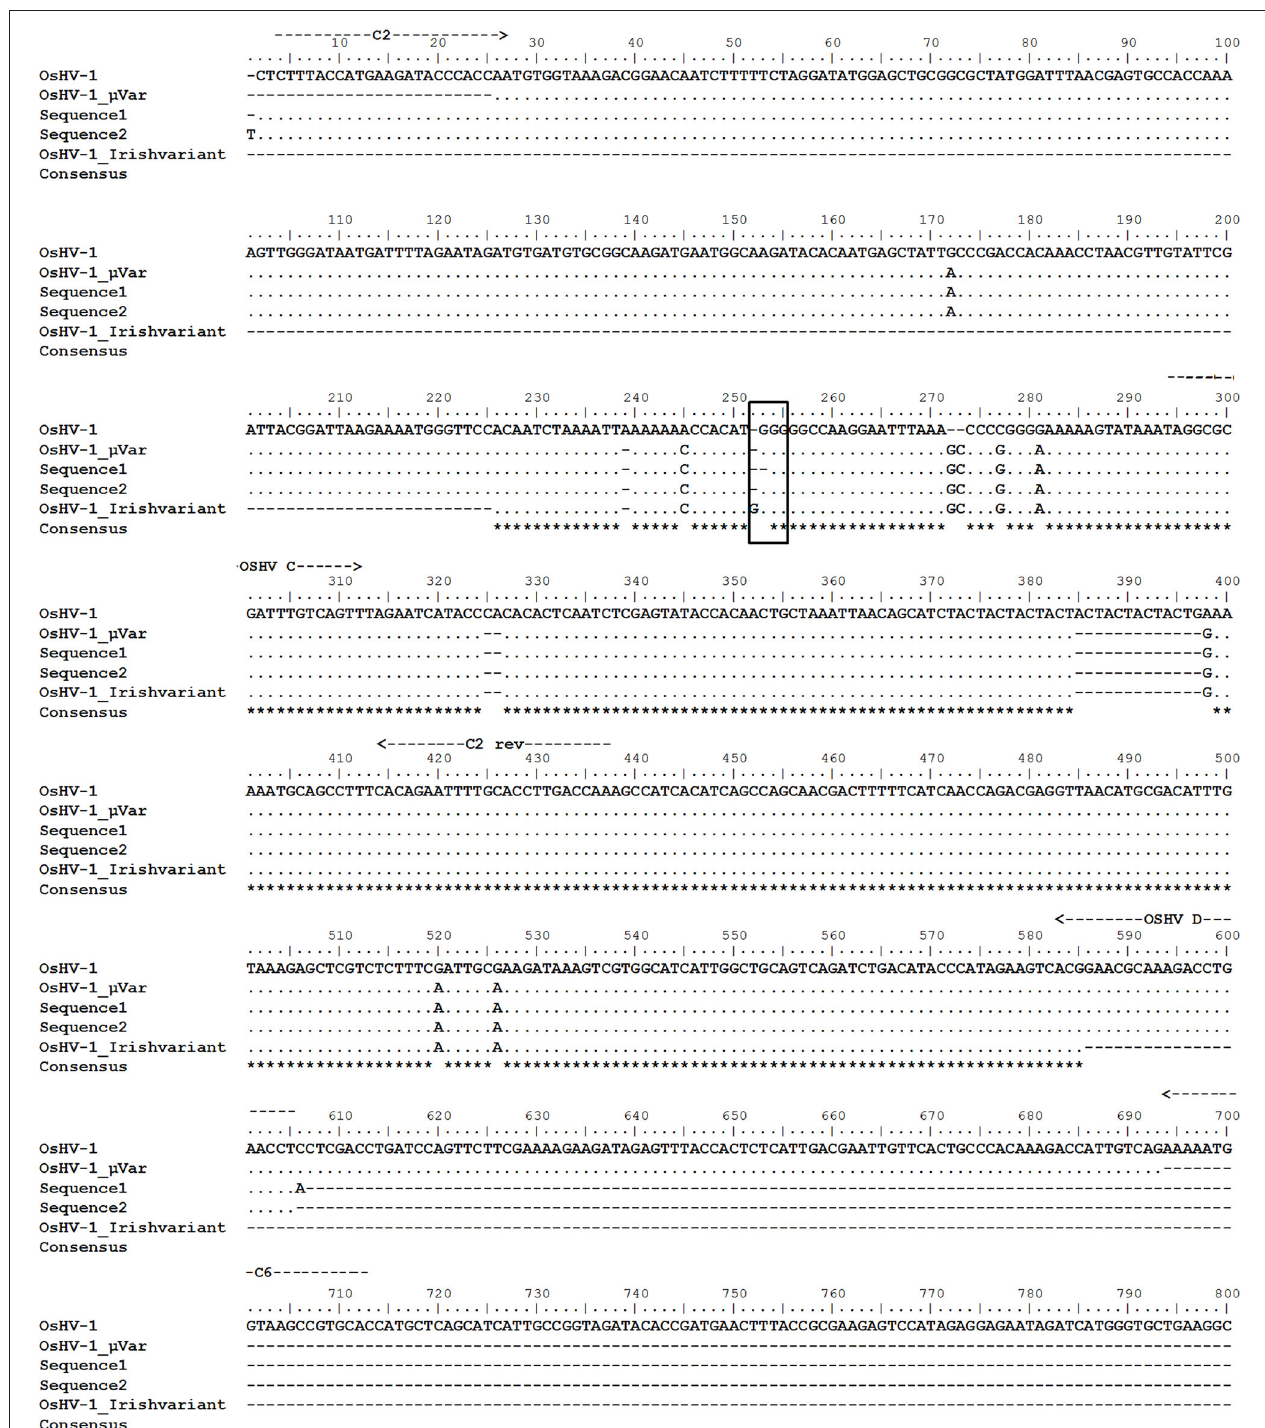
FIGURE 6 | Alignment of the nucleotide sequences obtained in this study (sequence 1 and sequence 2) with previously deposited sequences (OsHV-1 reference genome, acc num AY509253; OsHV-1 µ Var, acc num HQ842610.1; Irish OsHV-1 µ Var acc num JQ963169.1). Location of primers is indicated with arrows. Framed area indicates the location of the polymorphism found in sequence 2 compared to OsHV-1 µ Var. Asterisks indicate conserved residues.